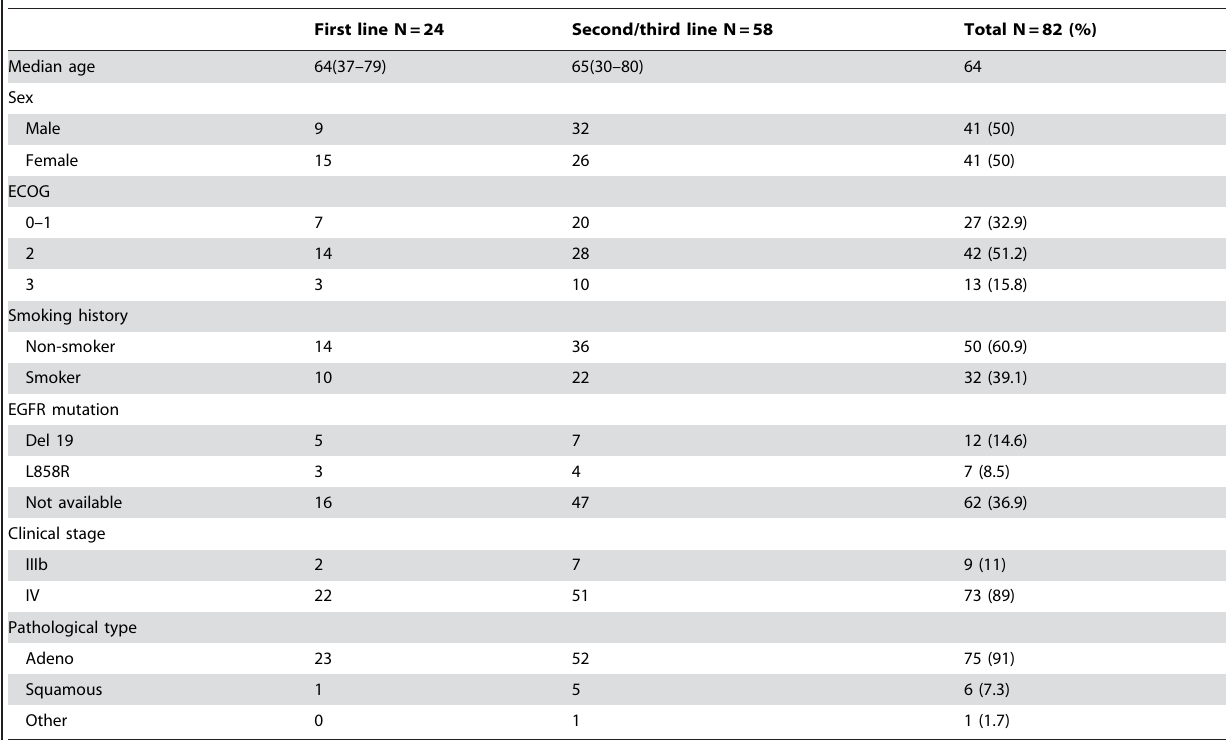
Table 1. Patient